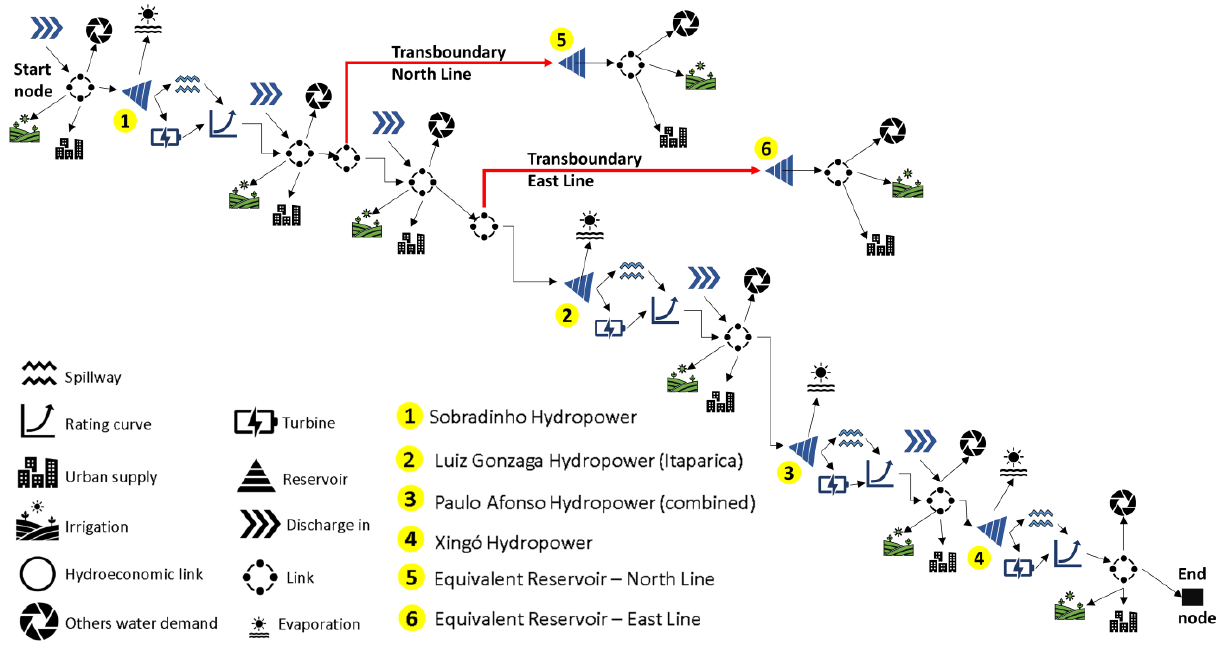
Figure 6. T opology of the São Francisco basin downstream from the Sobradinho hydropower and transboundary system for optimization of the network the transboundary system for optimization of the network flow.